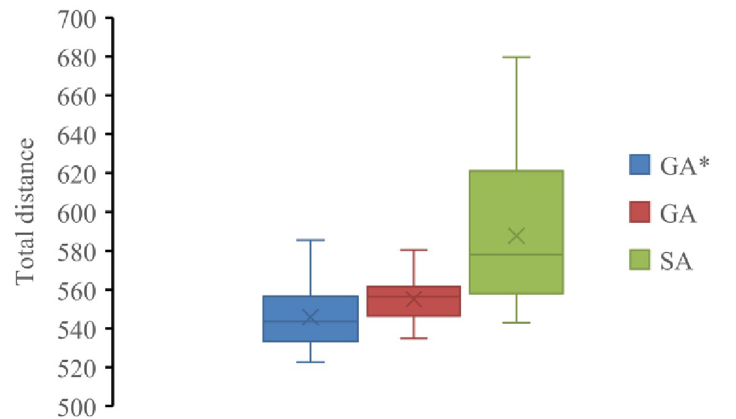
Fig 5. Different algorithm solution